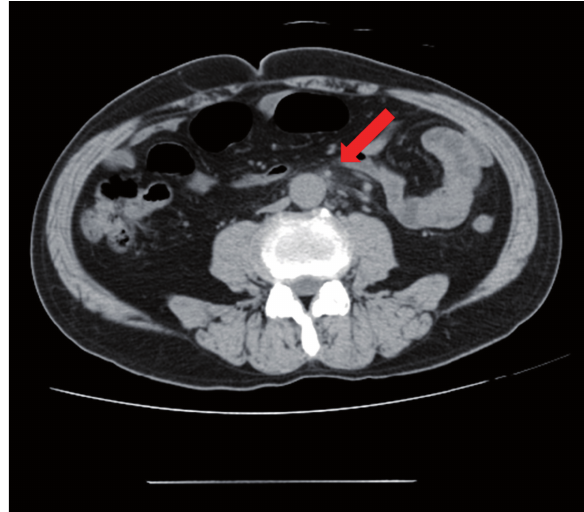
figure3 - B) The size of the retroperitoneal soft tissue mass decreased two months after